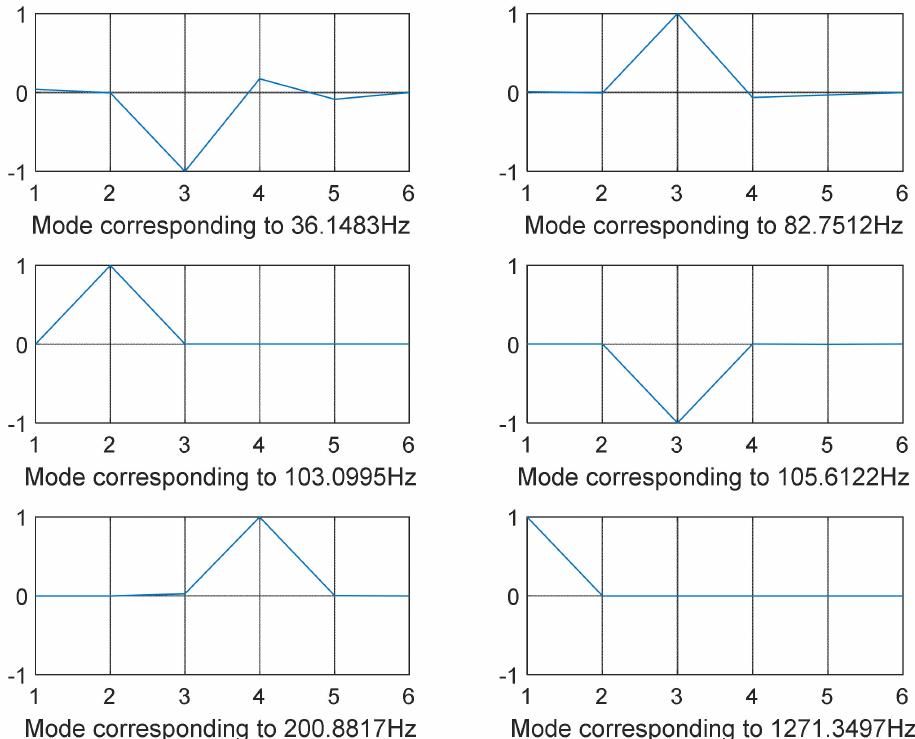
Figure 4. GWO-optimized mode shapes 7–12 (12-DOF model—shaking loads only).